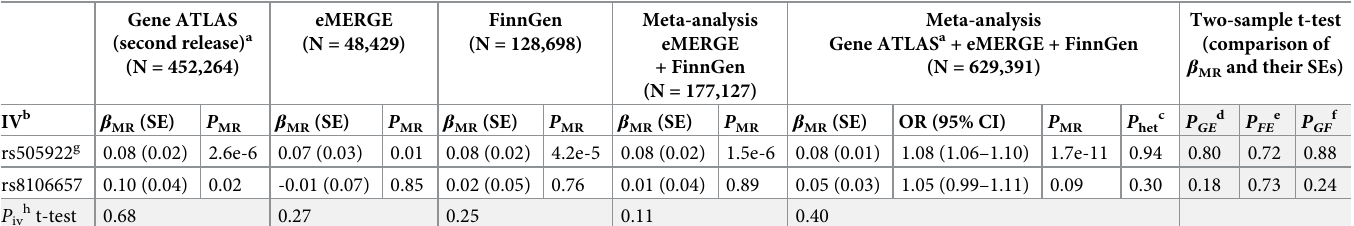
was 0.03, which is higher that the Bonferroni-corrected threshold of 0.025 (Tables 1 and S4). Besides this, β obtained using the eMERGE dataset had the opposite sign to β MR the Gene ATLAS- and FinnGen-based analyses (-0.09 vs. 0.14 and 0.12, respectively). Hence, although the P- value in the meta-analysis of the data for the three cohorts was 4.7 × 10 − 6 , we do not consider the association between MICB plasma level and VVs as replicated in our study.